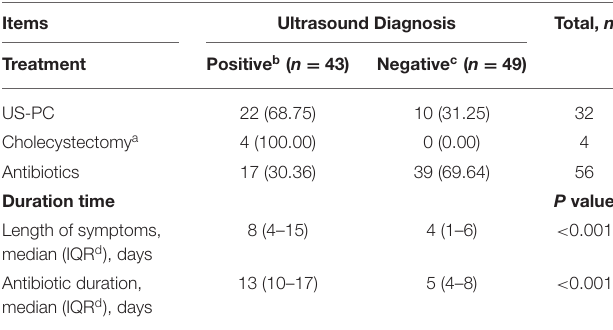
TABLE 6 | Summary of clinical treatment and the duration of cholecystitis symptoms and antibiotic therapy by ultrasound follow-up.